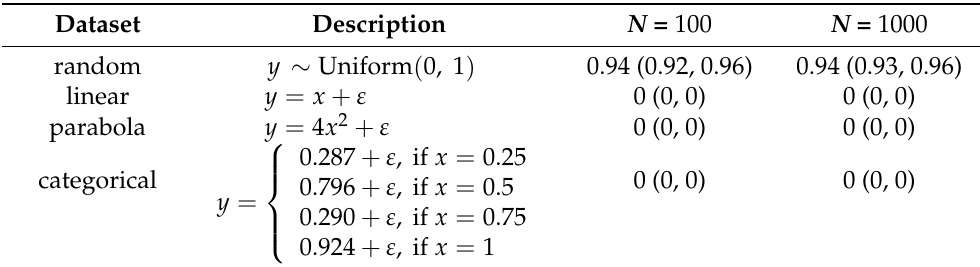
Table 1. Detection rates of independence with GIEF.